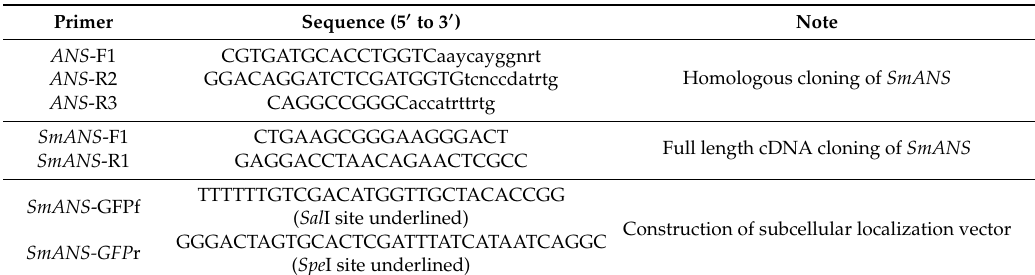
Figure A1. The phylogenetic tree of SmANS protein in Salvia miltiorrhiza and ANS protein in other plants. The red marke represents SmANS protein. Table A1. The primers used in this